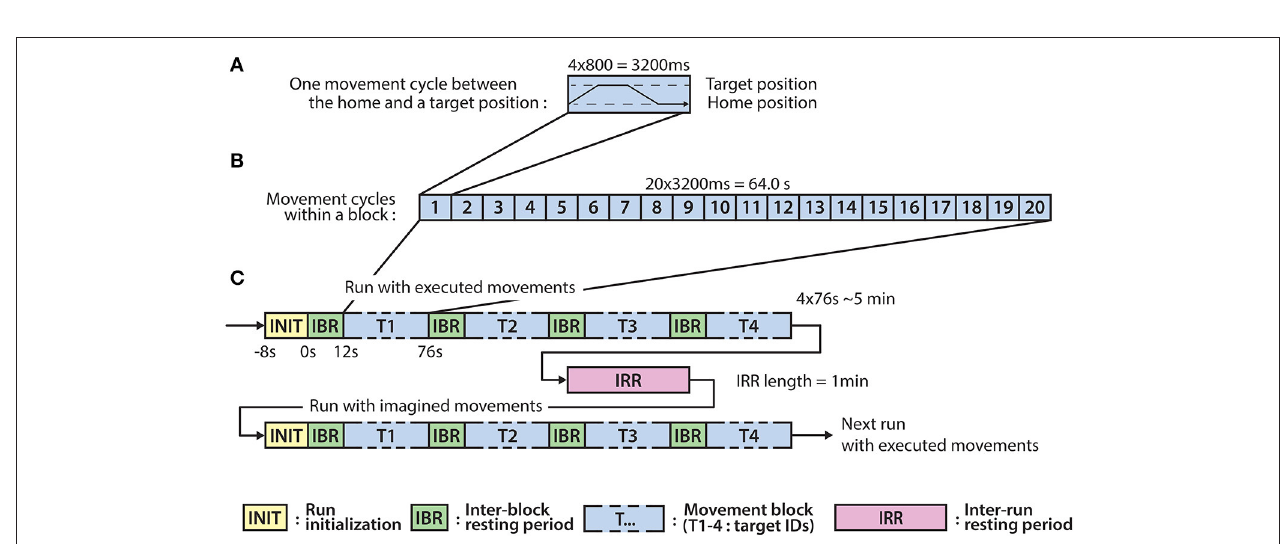
FIGURE 2 | Experimental paradigm. (A) The timing of an executed or imagined movement cycle (depending on the run) between the home position and one of the four target positions (T1-4). (B) The structure of a block comprising 20 movement cycles between the home position and one of the four target positions. (C) The structure of the runs involving executed and imagined movements. A run involving executed movements is followed by a run involving imagined movements and the runs are separated by inter-run resting (IRR) period. A run comprises four blocks corresponding to each of the four targets (T1-4) and the blocks are separated by an inter-block resting (IBR)